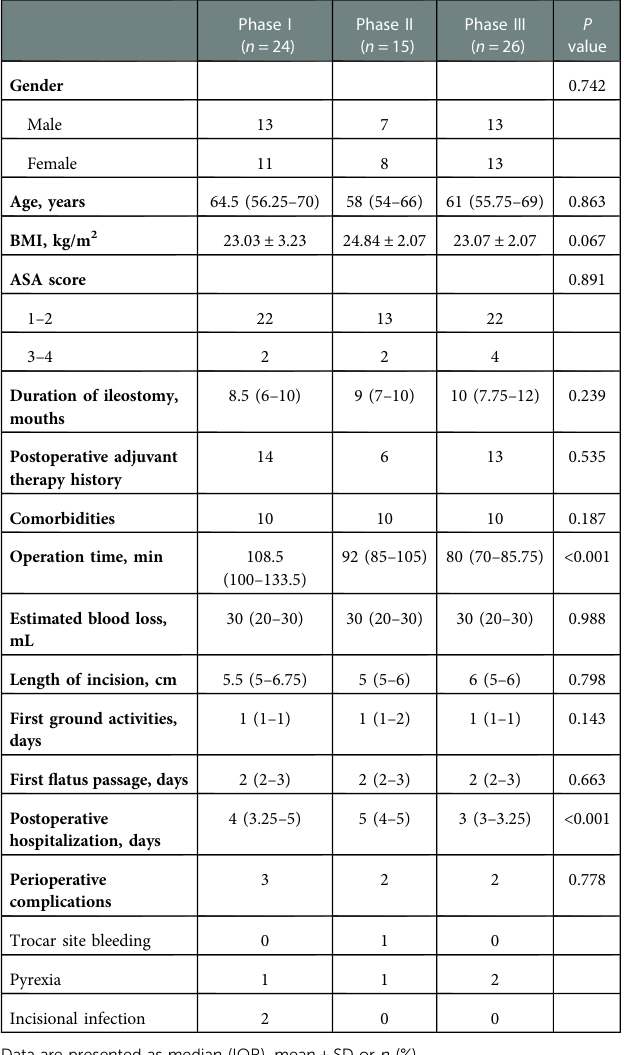
TABLE 2 Interphase comparisons of patient characteristics and perioperative